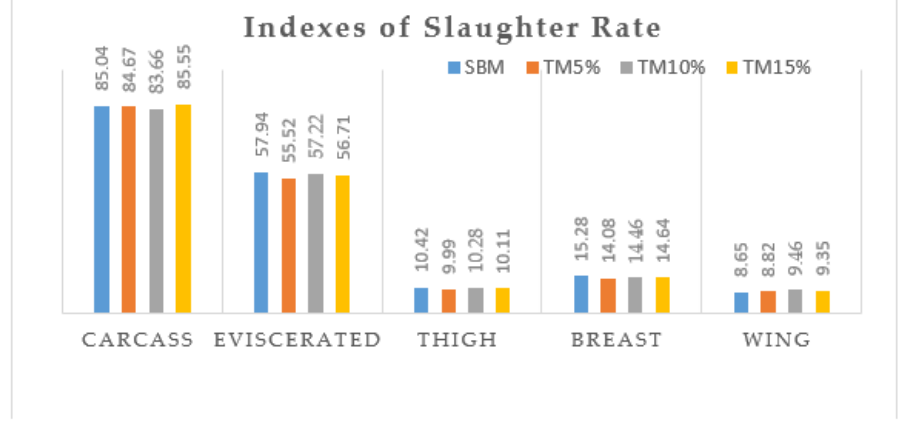
Figure 1. Indexes of slaughter rate of Boschveld chickens fed yellow mealworm. Indexes of Slaughter rate were calculated as carcass weight/live weight × 100; Evis- cerated weight/live weight × 100; Thigh muscle/live weight × 100; Breast muscle/live weight × 100 and wing muscle/live weight × 100. Raw and cooked mixed-sex Boschveld indigenous chickens’ meat quality parameters are presented in Table 4. The soybean fed group (SBM) were heavier ( p < 0.05) than the experimental group (TM15). The cooking loss was lower in the SBM control group as compared to TM15 ( p < 0.05). However, no differences existed between control, TM5 and TM10 group. The internal temperature was measured immediately after removing the breast meat from the oven. The breast (both left and right) internal temperature was higher in the TM15% group and lower in the SBM group. Colour characteristics was also measured before and after cooking. The values for lightness (before cooking) ranged from 61.7 to 69.3 and this was significant ( p < 0.05). The TM10 and TM15 group showed lighter colours than the SBM and TM5 groups. No significant ( p > 0.05) differences were observed for the a*, b* values; similarly, the colour of the breast meat after cooking did not differ in lightness, redness and yellowness. The breast meat from the TM5 group had a lower